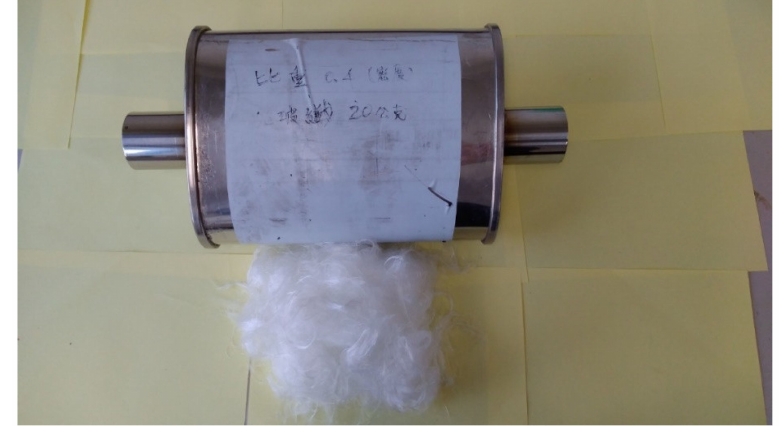
Figure 2. The glass fiber with muffler.